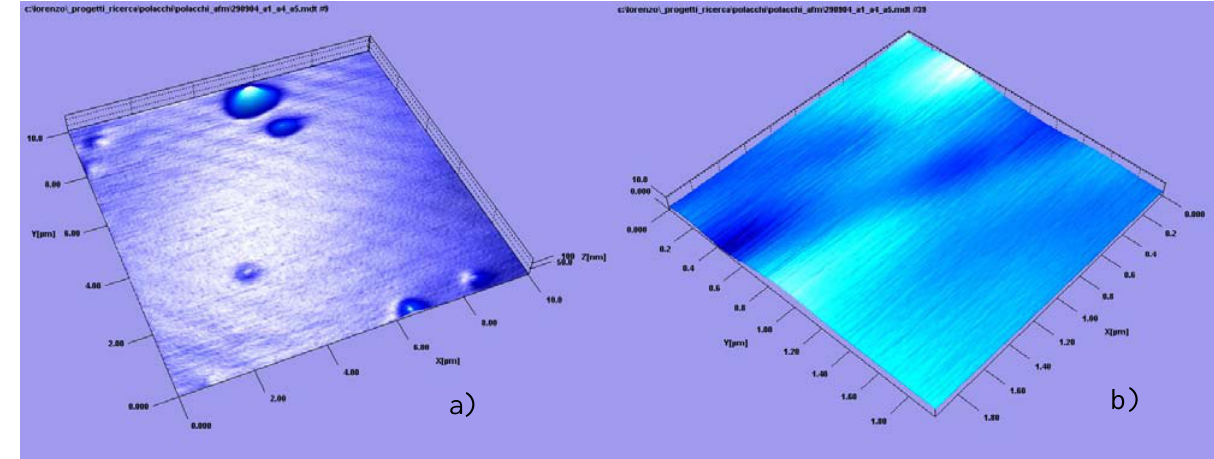
Figure 3. 3D AFM-images for the surface of non-modified silicon samples (a) and modified with APTS and GA